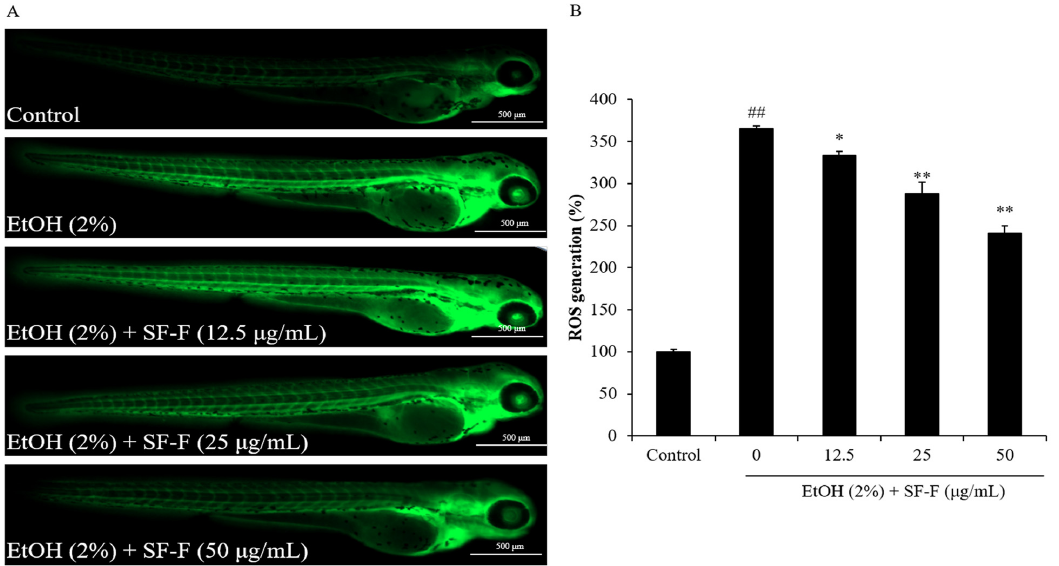
Figure 4. The protective effect of SF-F during EtOH-induced ROS production in zebrafish. ( A ) Zebrafish under fluorescence microscope; ( B ) the levels of ROS generation. ROS was detected by DCFH2-DA staining and ROS levels of EtOH-treated zebrafish were measured by ImageJ software. The experiments were conducted in triplicate, and the data are expressed as the mean ± SE ( n = 3). * p < 0.05, ** p < 0.01 as compared to the EtOH-treated group and ## p < 0.01 as compared to the control group.